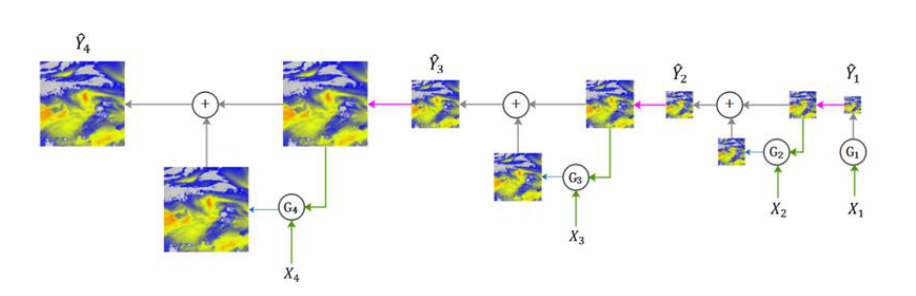
Figure 2. Multi-scale architecture. The generator starts with a noise sample 𝑋 1 (right side) and use a generative model 𝐺 1 to generate Ŷ 1 . Then the images are upsampled (pink arrow) and used as the conditioning variable for the generative model at the next level 𝐺 2 Together with another noise sample 𝑋 2 , 𝐺 2 generates a difference image which is added to up sample Ŷ 1 to create Ŷ 2 . This process repeats across two subsequent levels to yield a final full resolution sample Ŷ 1